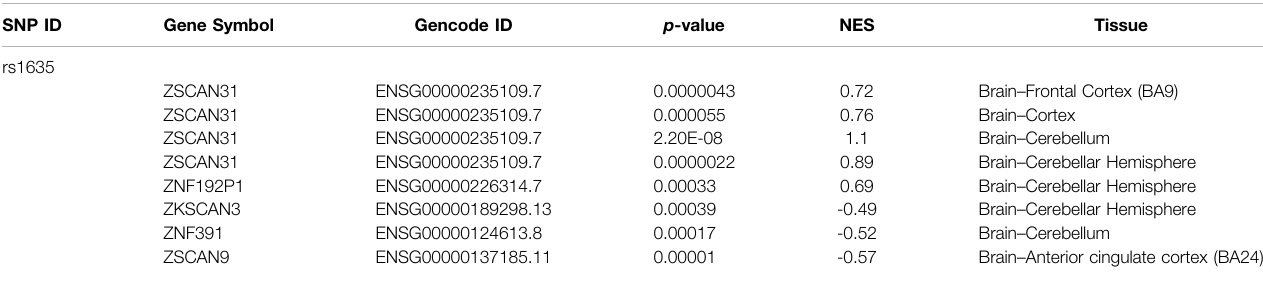
TABLE 3 | The eQTL analyses for rs1635 gene using the GTEx